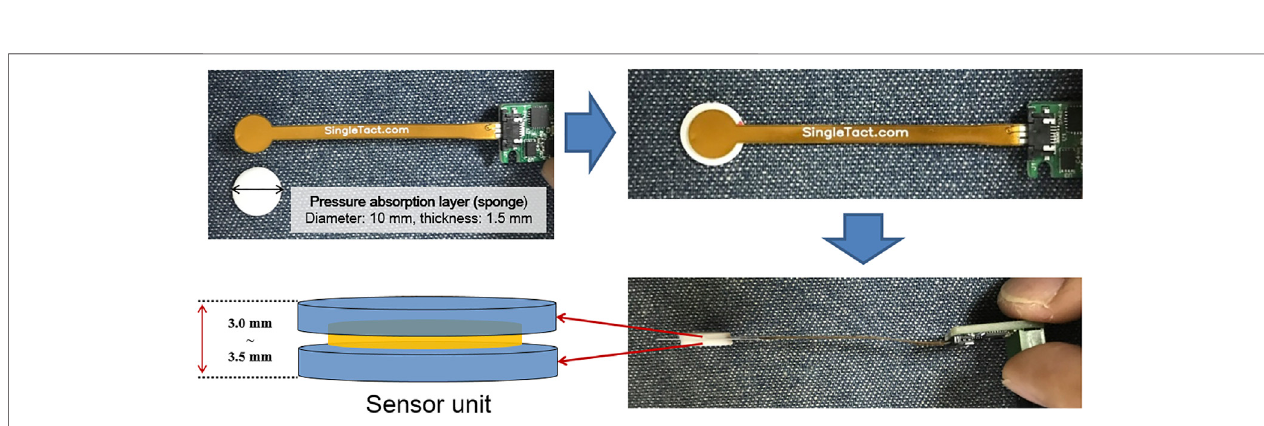
FIGURE 2 | Sensor unit consists of a force sensor and pressure absorption layer (PAL). The total thickness of the sensor unit in this study is 3.0 – 3.5 mm.